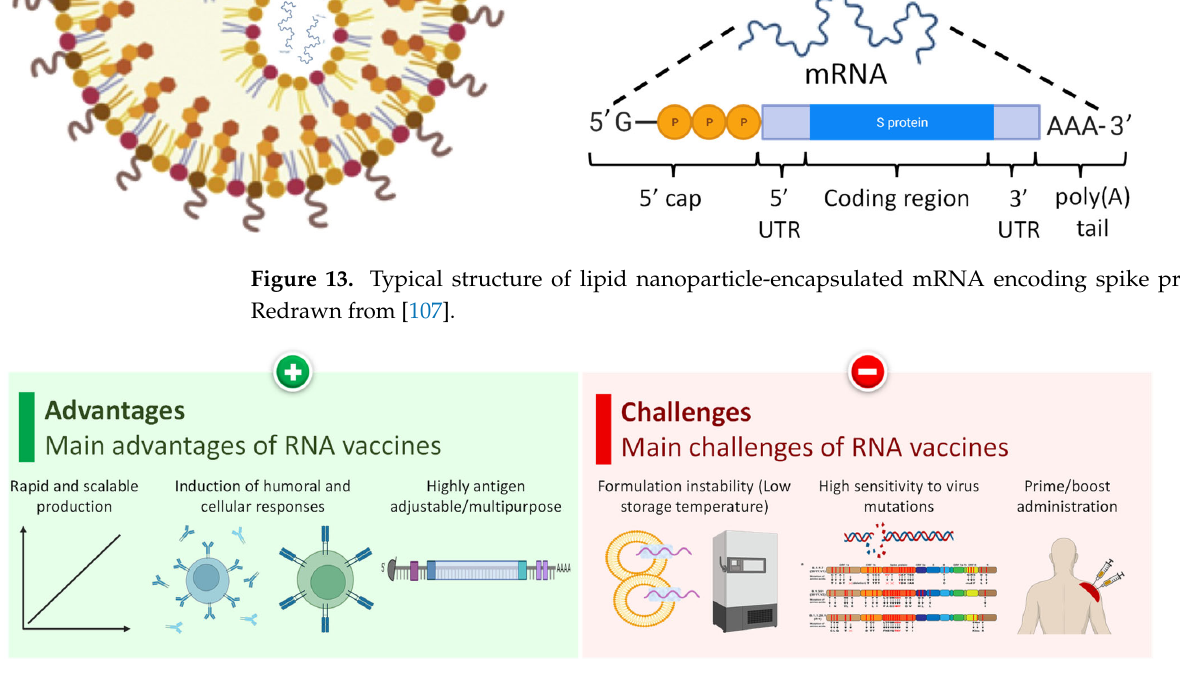
Figure 14. Advantages and challenges of RNA ‐ based vaccines. Modified from